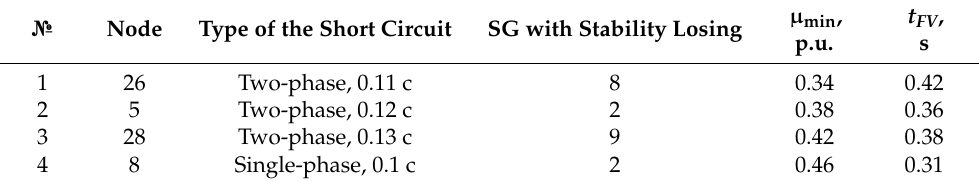
Table 6. Results of synthesis of emergency control laws for various disturbances. № Node